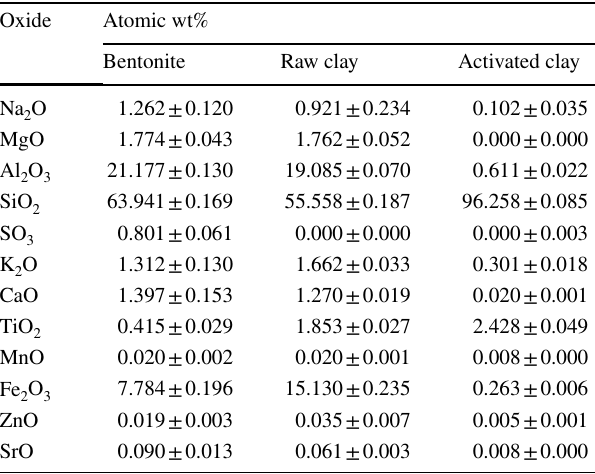
Table 3 Metallic oxide composition of the clay samples as measured by µ-XRF